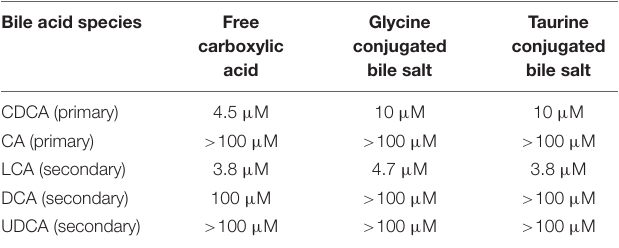
TABLE 1 | Potency of natural bile acids for FXR biding (modified according to Gioiello et al., 2014). Bile acid species Free